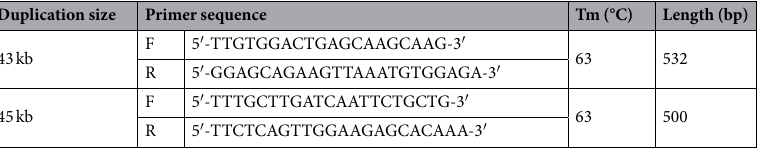
Table 2. Primer sequences used for the segregation analysis of the two novel MCDR3 duplications identified in the study. Tm = Temperature of melting.